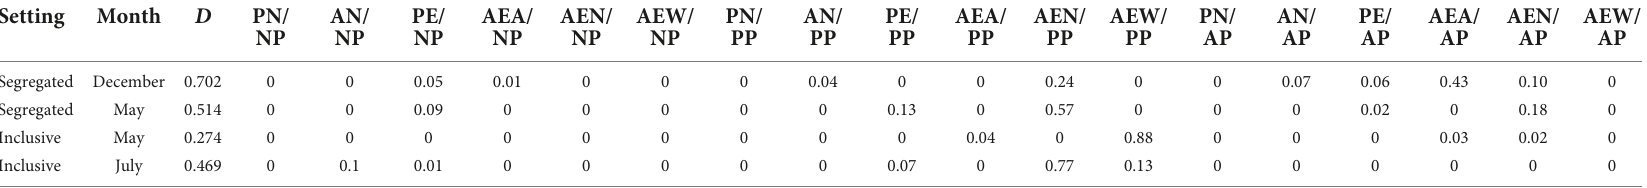
TABLE 2 Frequencies of states, child engagement, and adult participation during gross motor activities.